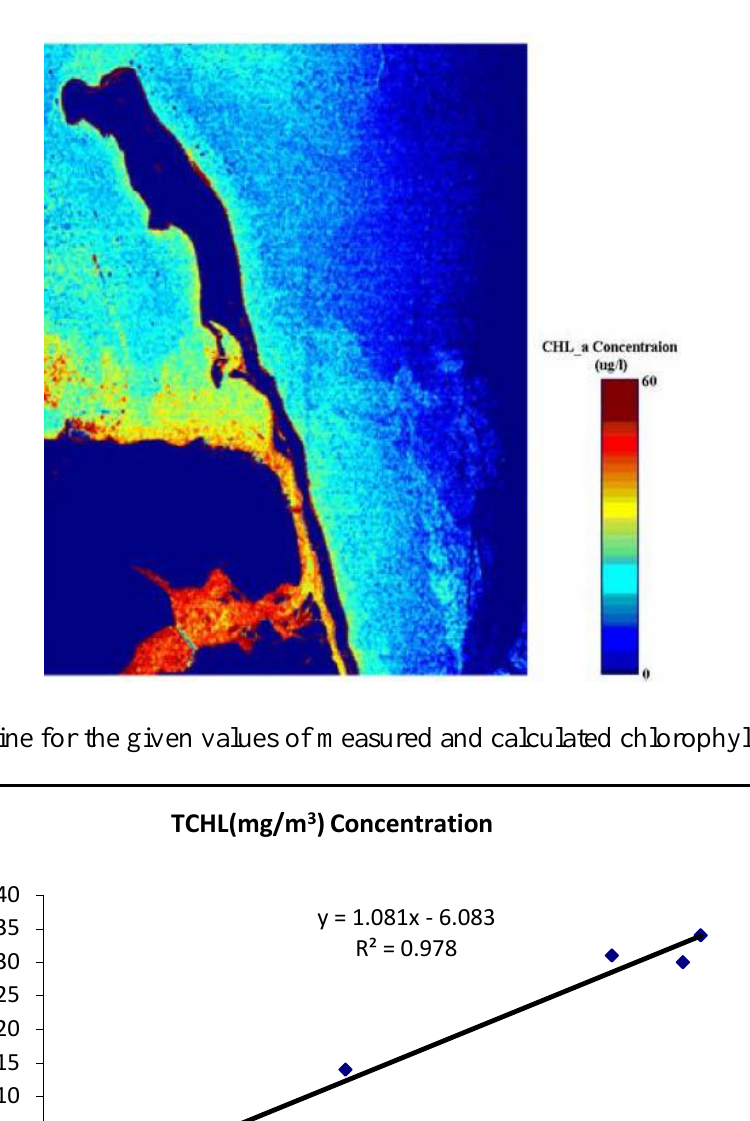
Figure 4. Spatial distribution of chlorophyll concentration based on band ratio of AVIRIS atmospherically corrected data covering Sandy Hook segment of Transect 3 (T3 on Figure 1).